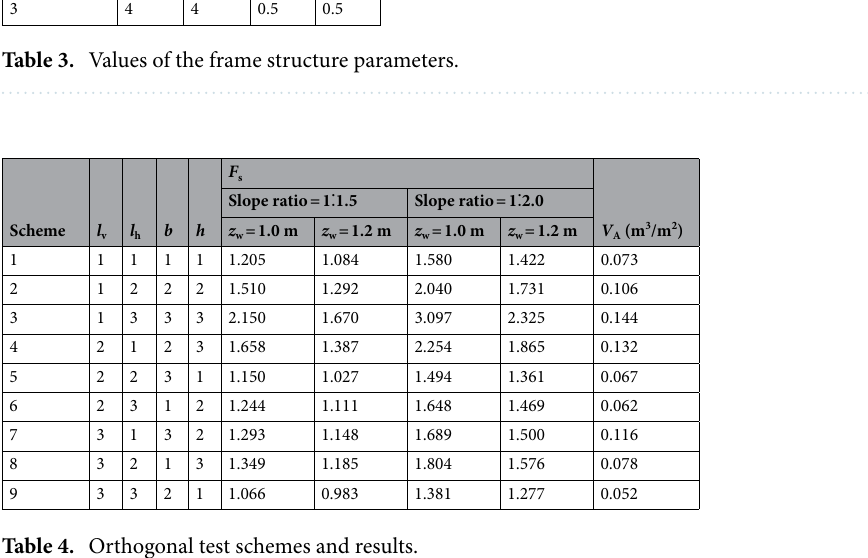
Table 4. Orthogonal test schemes and